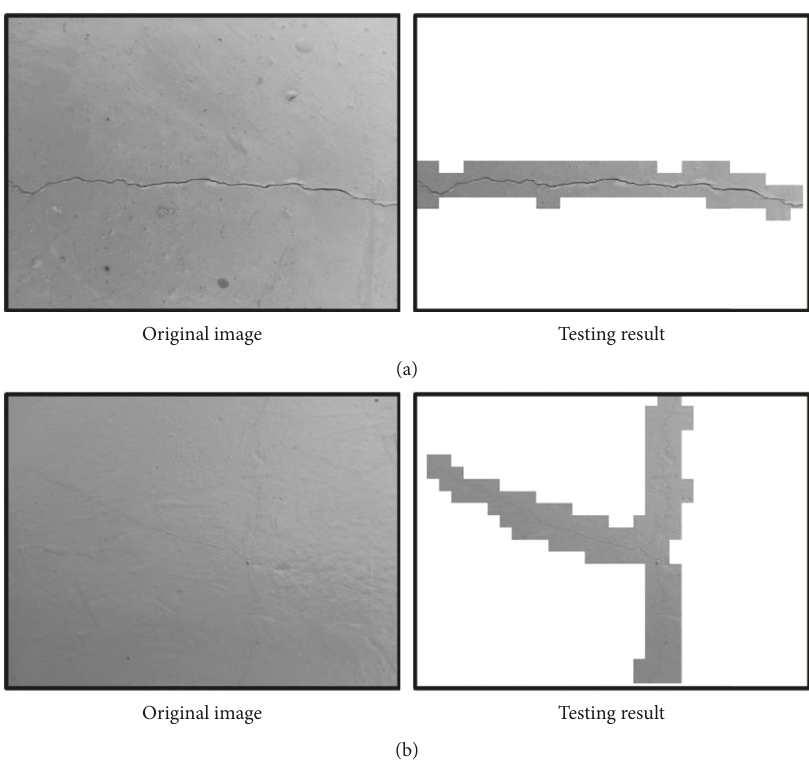
Figure 11: Normal surfaces: (a) clear crack; (b) microcracks.